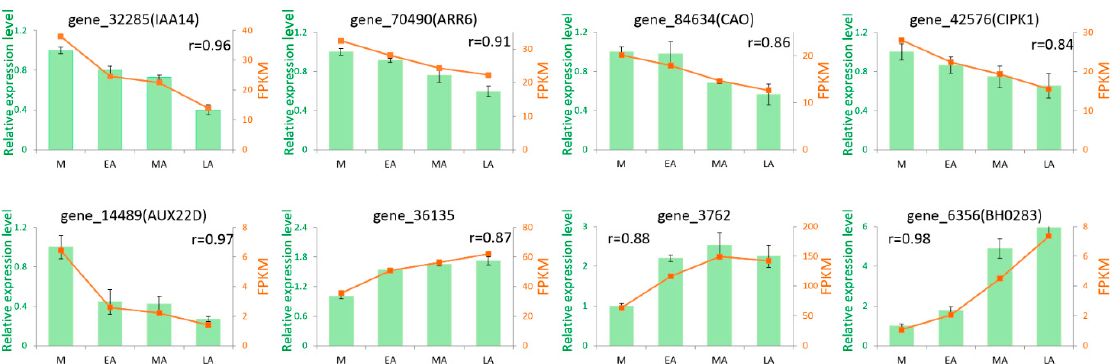
Figure 6. qRT-PCR validation of selected transcripts in tobacco leaves. The green columns represent the relative intensity of real-time quantitative RT-PCR (left y -axis), the red lines represent the FPKM value of the transcripts (right y -axis). The x -axis refers to the four stages of premature senescence. Error bars refer to standard error (n = 3). The values of r mean the Pearson correlation coefficient of data between RNA-seq and qRT-PCR.